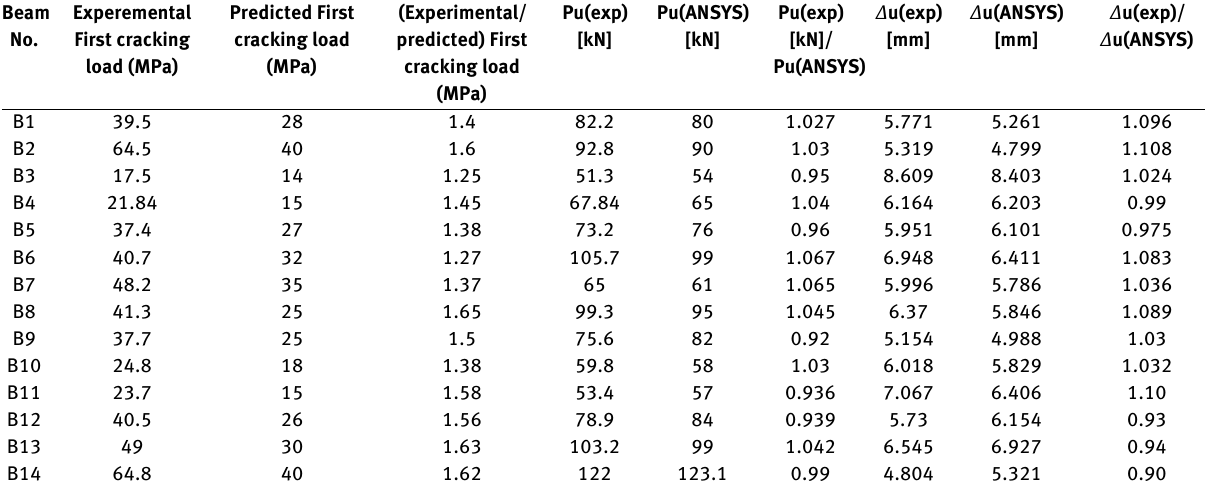
Table 9: Experimental and predicted, first cracking load, ultimate load capacity, and ultimate deflection for all tested specimens Beam No.